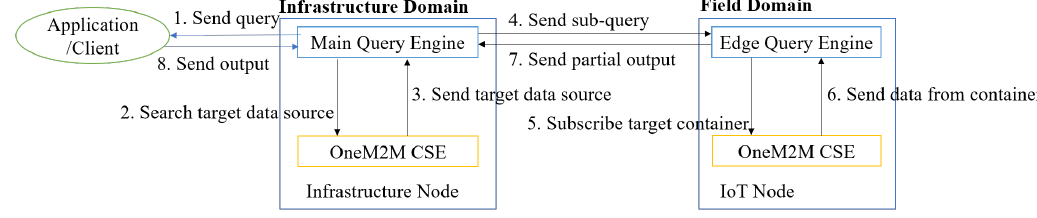
Figure 4. The proposed oneM2M query